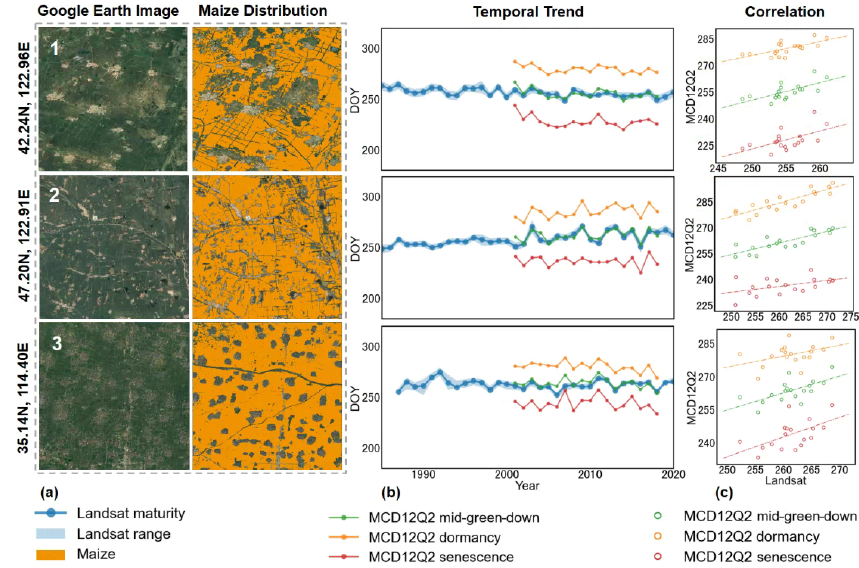
Figure 11. Representative cases of phenology comparison between MODIS and Landsat-derived results. Selected cases of maize (including the raw © Google Earth images and the distribution of maize) are displayed in (a) , with the comparison of their temporal trends (b) and corrections (c) . Cases 1–2 are the spring maize, and case 3 is the summer maize. Each scene represents a 1.5km × 1.5km square. Note that solid lines represent the mean phenology at the regional scale, and the shadowed areas represent the range from 25th to 75th quantiles of maturity date derived from Landsat.